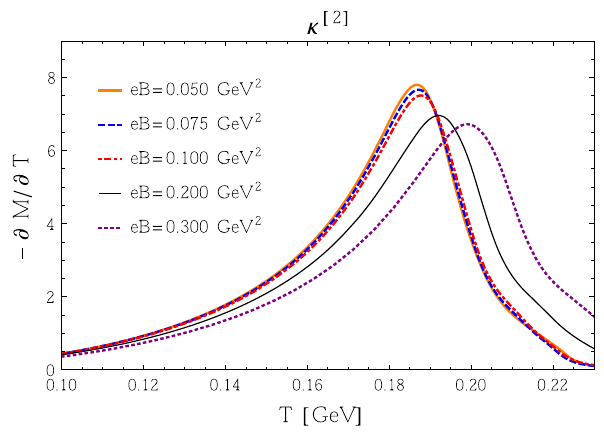
Fig. 5 − ∂ M /∂ T as function of the temperature, for different fixed values of magnetic field with fixed κ [ 2 ]